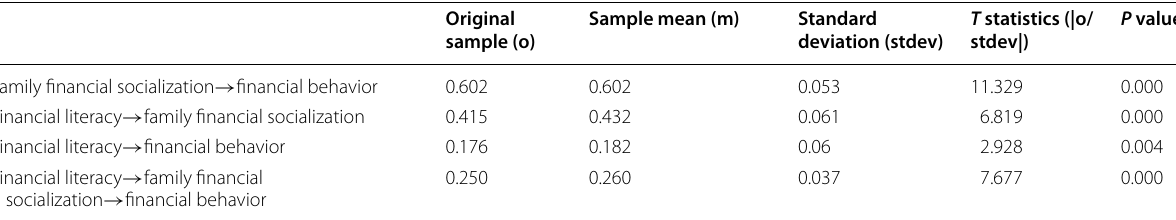
Table 6 Relation between IV, DV and